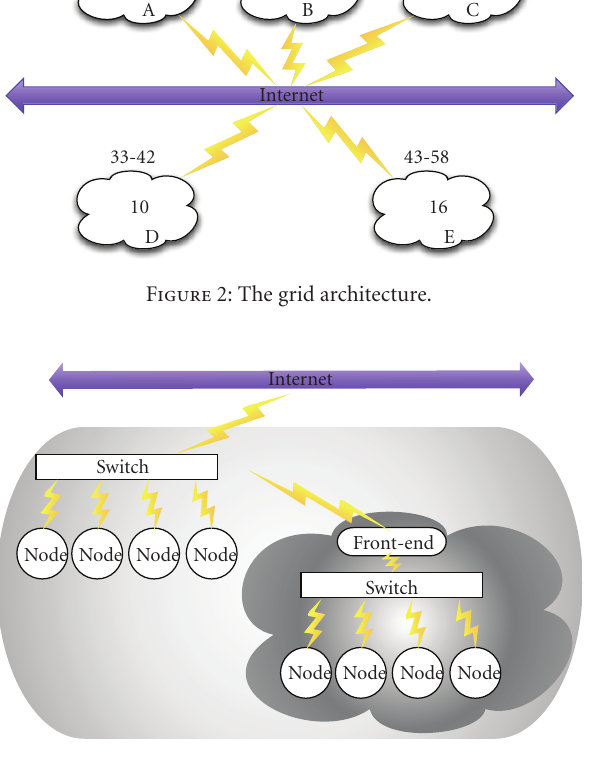
Figure 3: An example of site B. Table 1: Power of nodes for each site expressed in MIPS. Sites